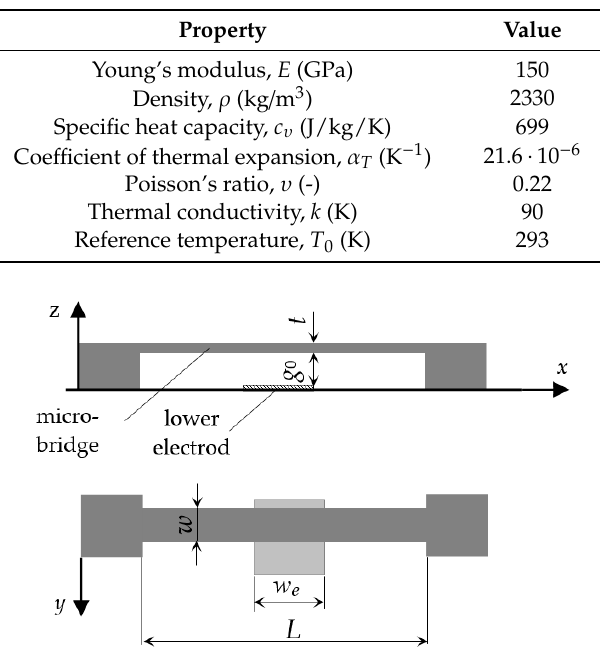
Table 2. Comparison between analytical and experimental results.